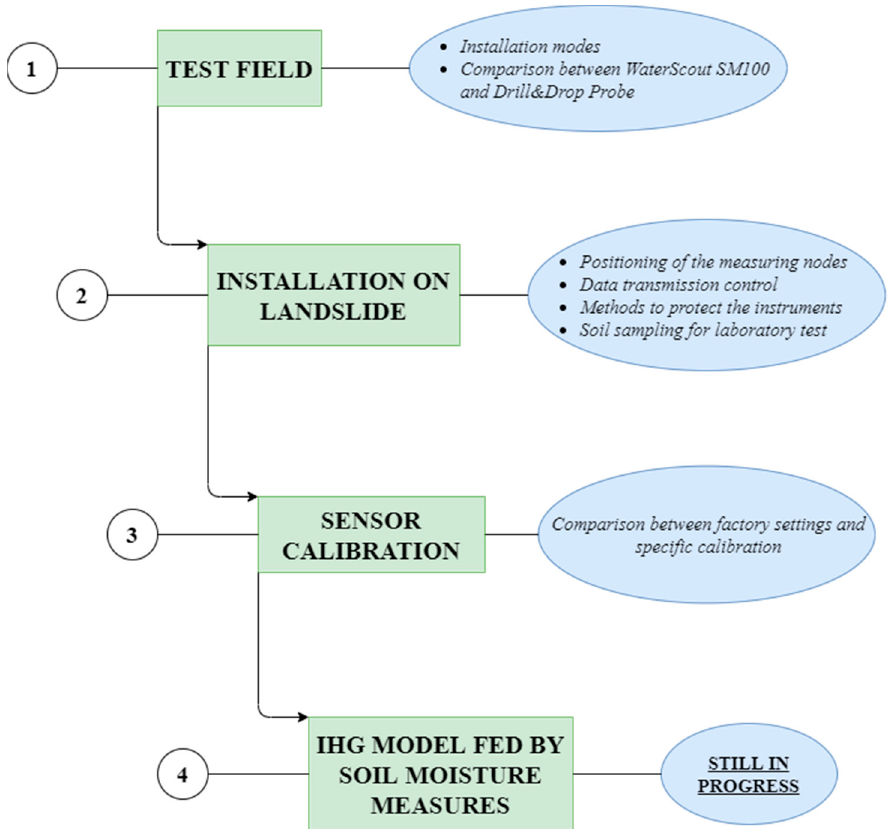
Figure 1. Chronological chart of the research activities.